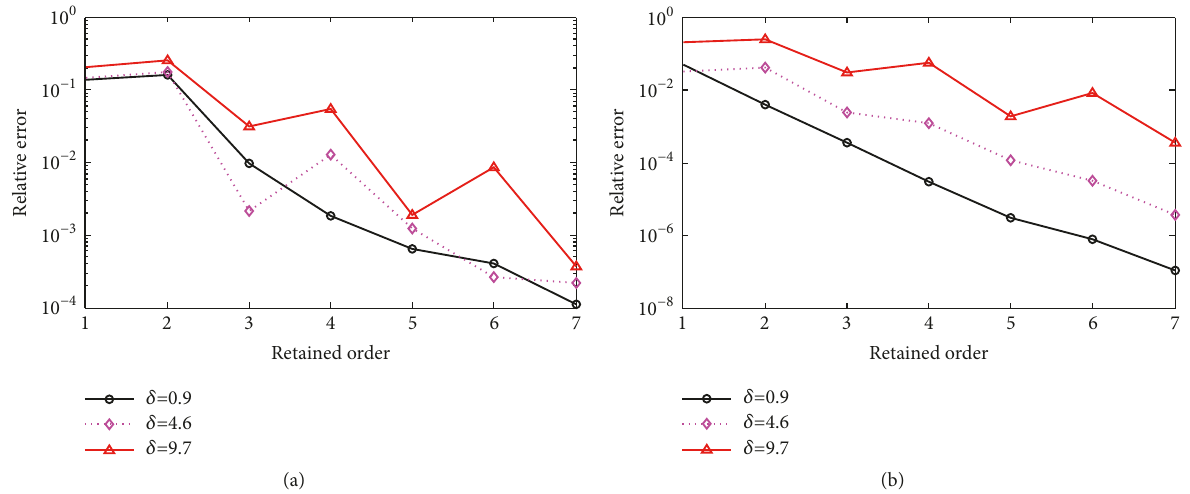
Figure 2: Convergence behavior of Jacobi expansion with different Jacobi parameters for the calculation of the mean and variance of y: (a) mean; (b)